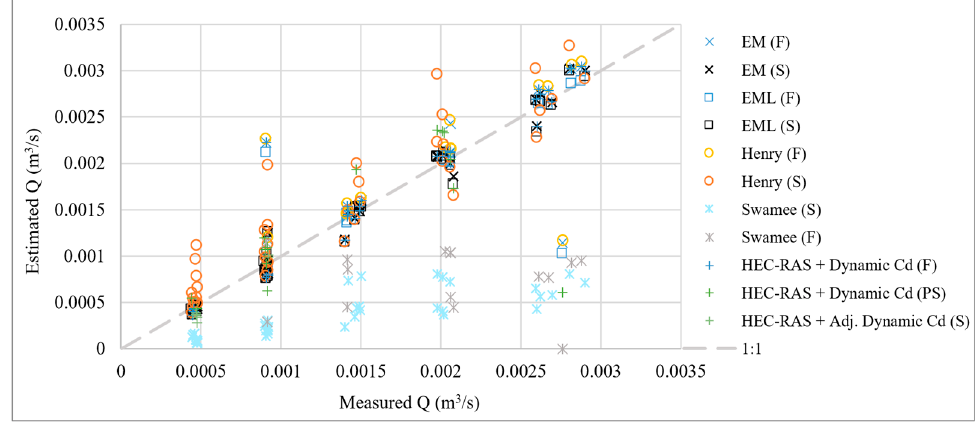
Figure 8. The estimated volumetric flow rate of all models compared to corresponding measured flow rates. Table 5. Evaluation of models in estimating the flow rate in the full sluice gate operation range.